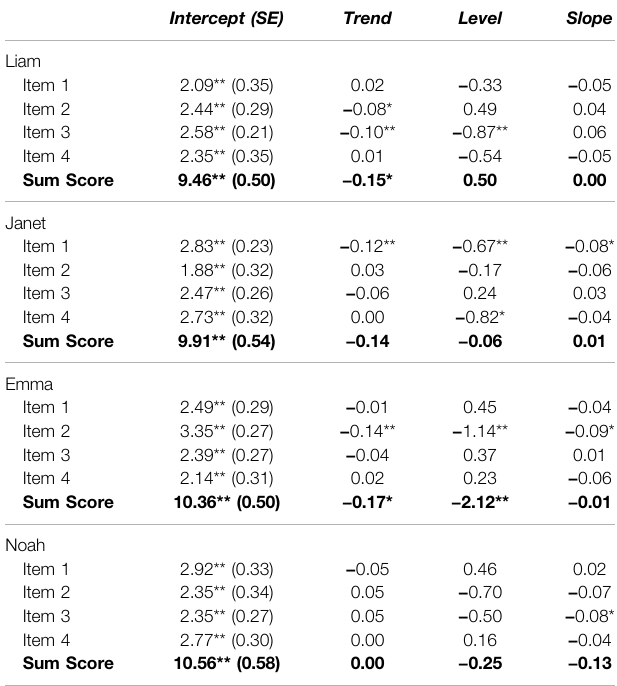
TABLE 3 | Piecewise regression analyses for the single behavior scores and the DBR-MIS sum scores for each student. Intercept (SE) Trend Level Slope